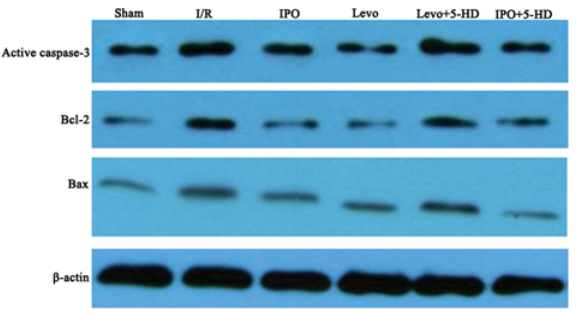
Figure 2. Western blotting results of active caspase-3, Bax and Bcl-2 in different groups.